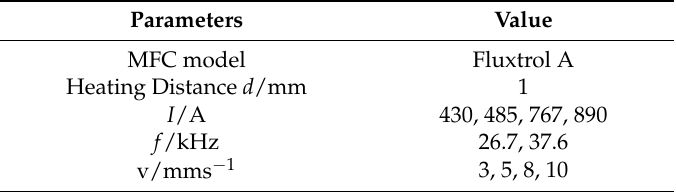
Table 1. Experimental parameters of the planar moving induction heating.